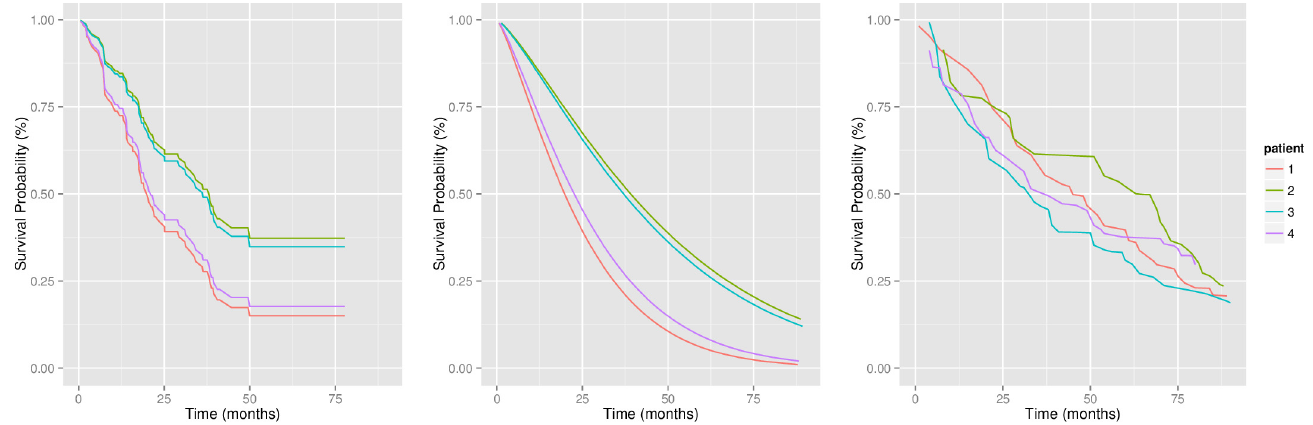
Fig 7. Survival curves for several patients from North Alberta Cancer Dataset [34], generated by (a) Cox model; (b) AFT model; (c) MTLR.